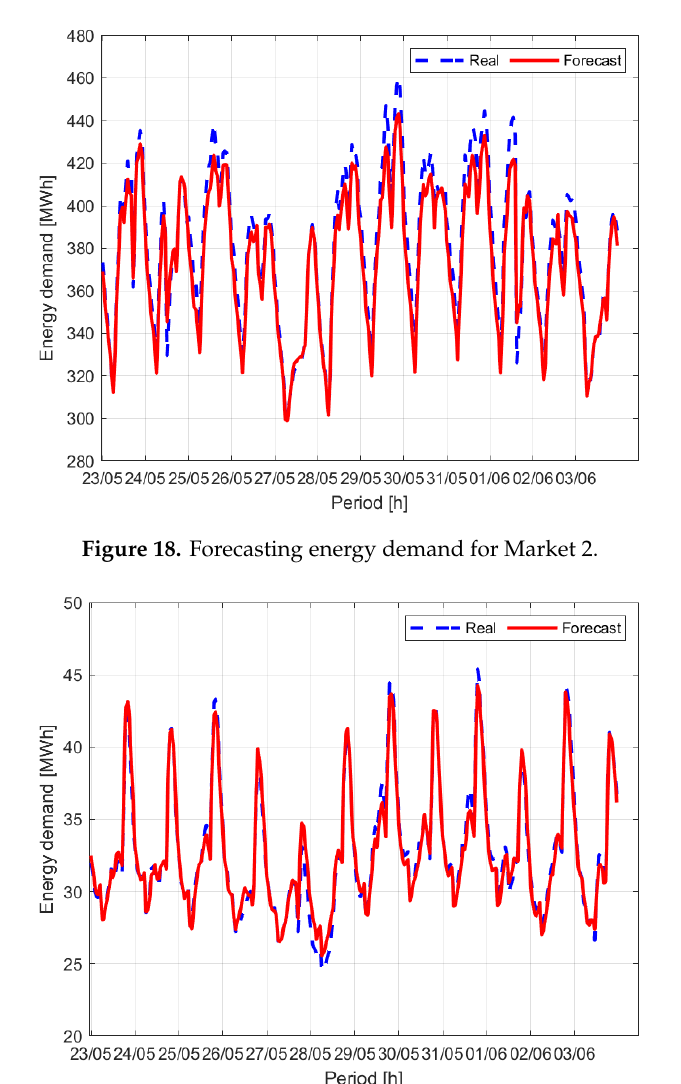
Figure 17. Forecasting energy demand for Market 1. Energies